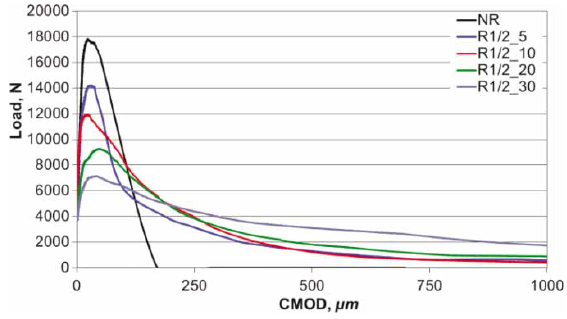
Fig. 5. The function of stress and CMOD when 1/2 fraction is used